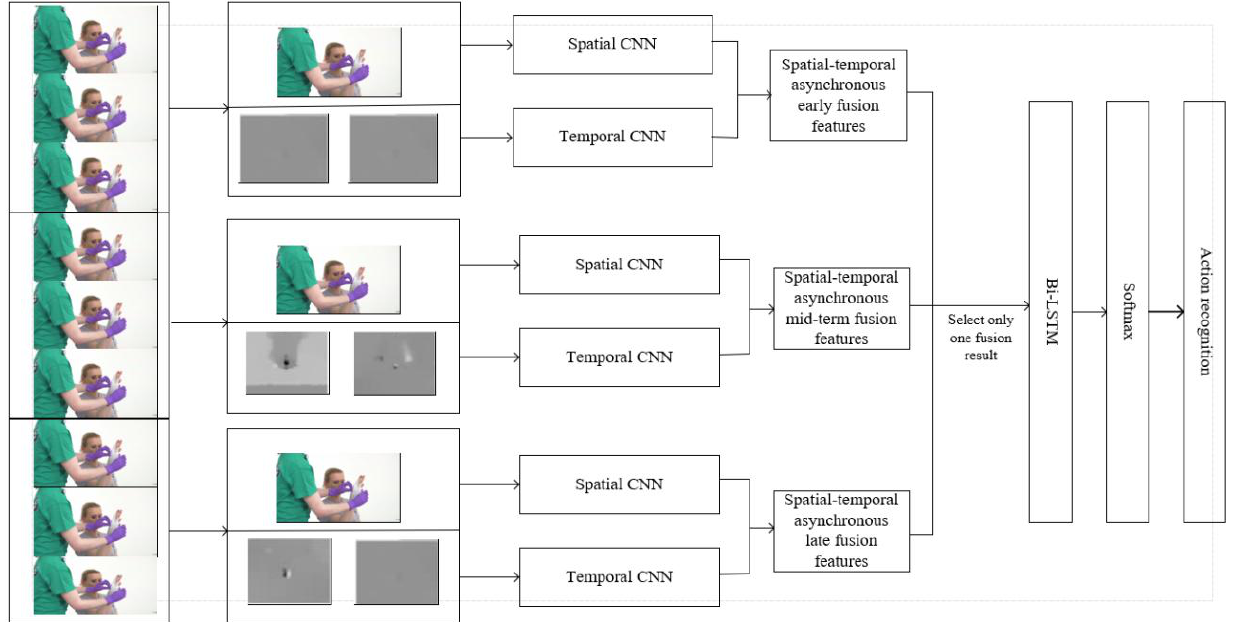
Figure 2. The proposed structure of the spatial-temporal fusion